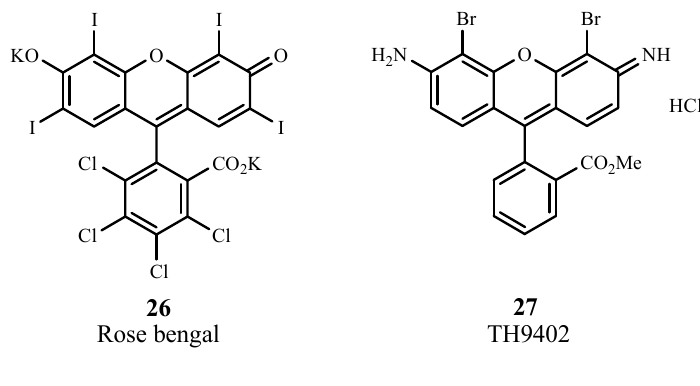
Figure 18. Examples of xanthene PDT sensitizers.